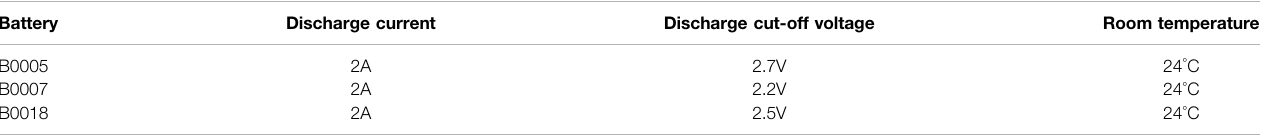
TABLE 2 | Discharge test conditions of lithium-ion battery.